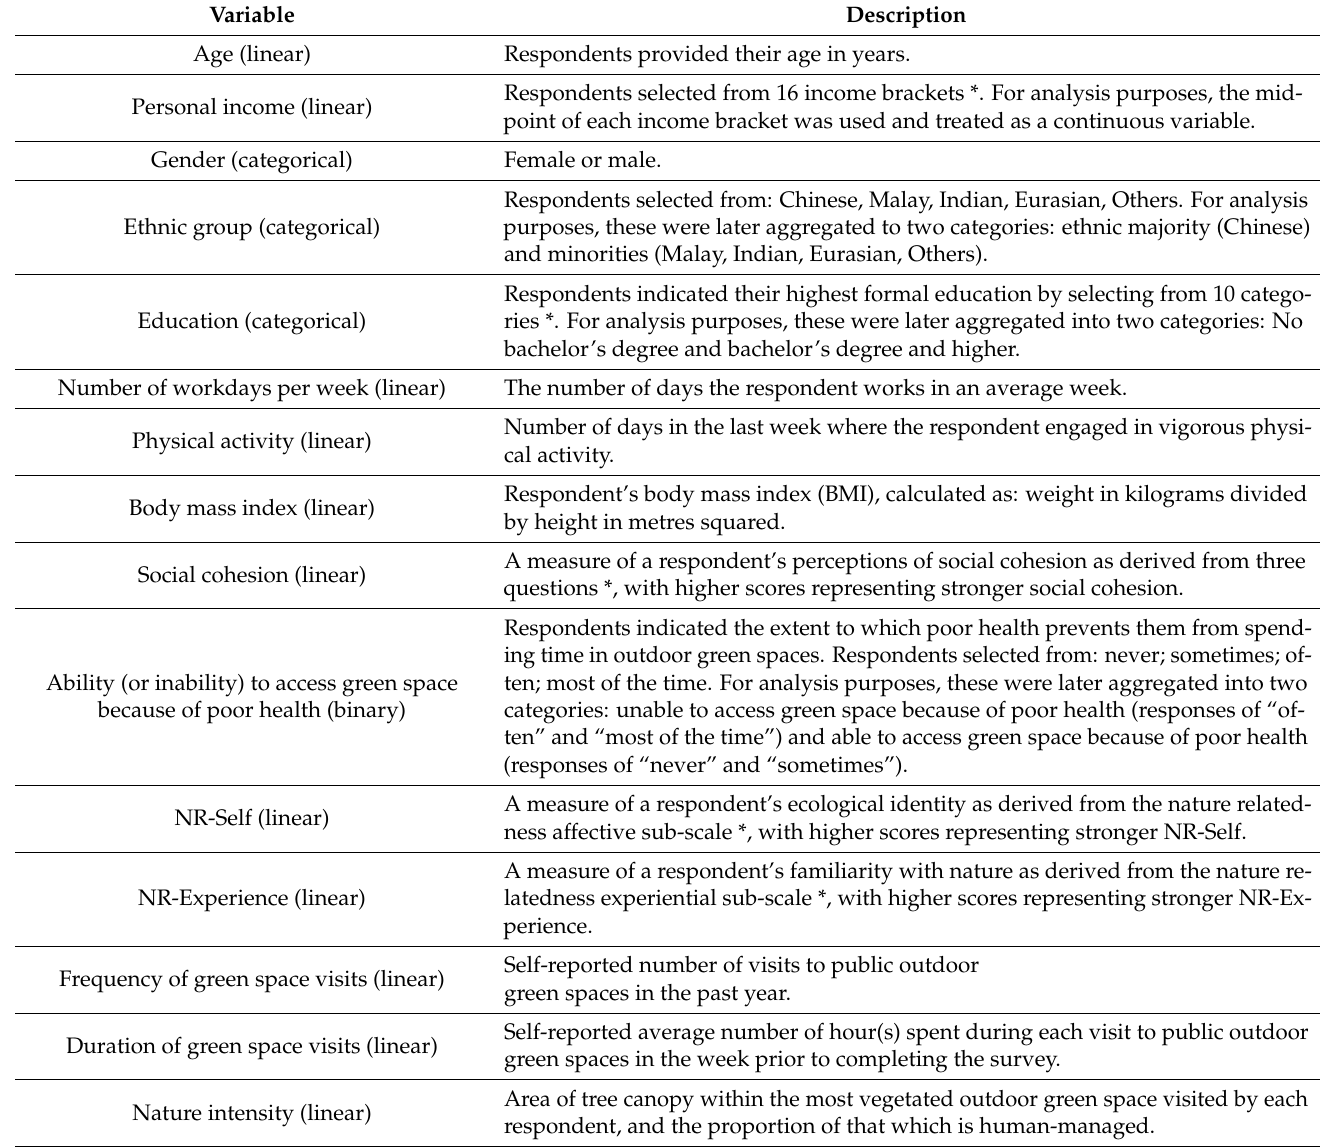
Table 1. Description of the predictor variables specified in each of the five global models where response variables are depression, anxiety, stress, high blood pressure, and